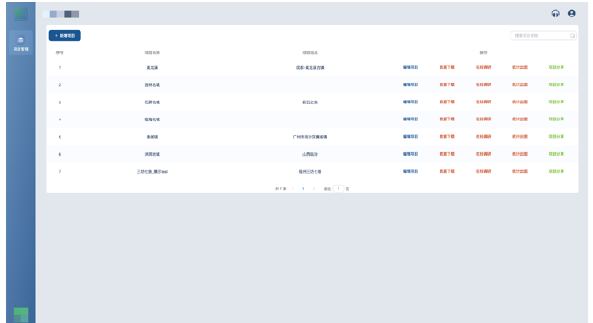
Figure 4 . Project Management Page in Backstage Management System.